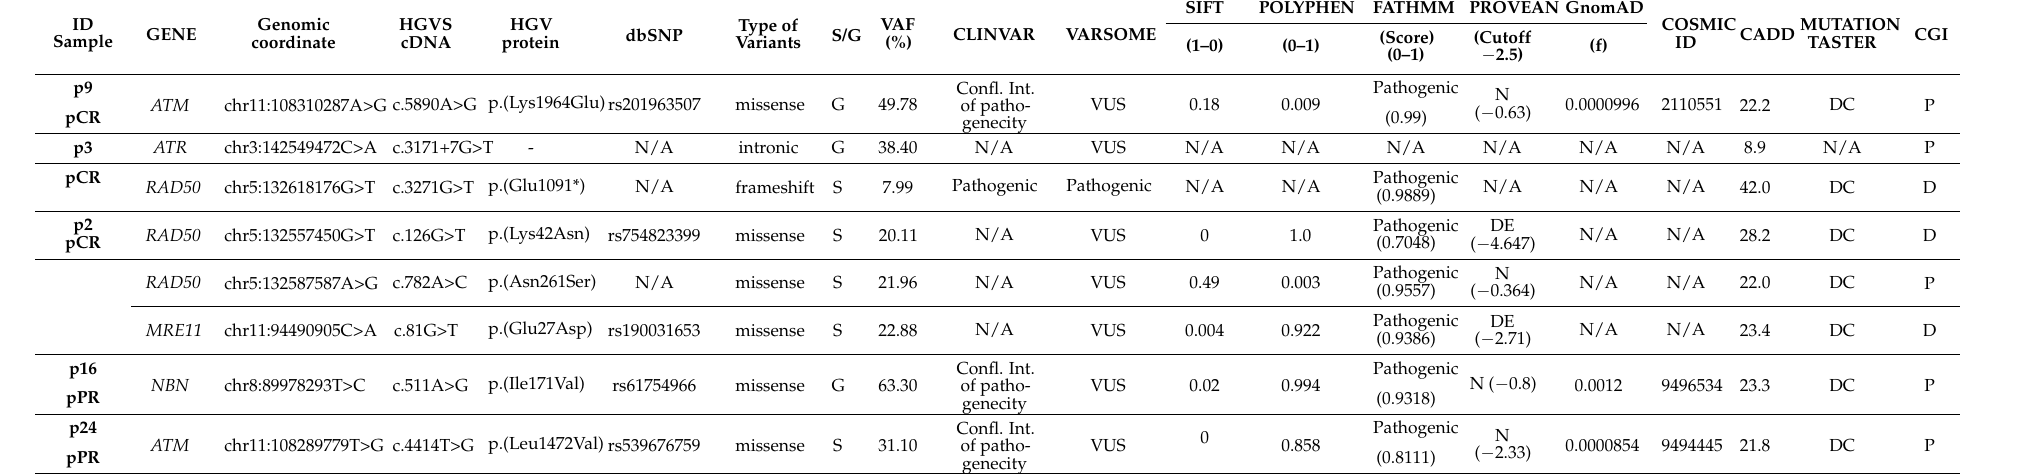
Table 2. Class 1–3 variants identified in the study in FFPE tumor